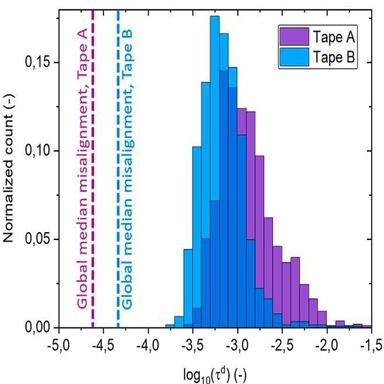
Histogram of the logarithm of differential tortuosity for the two tapes. The dashed lines represent the tortuosity related to the fibres global median misalignment.